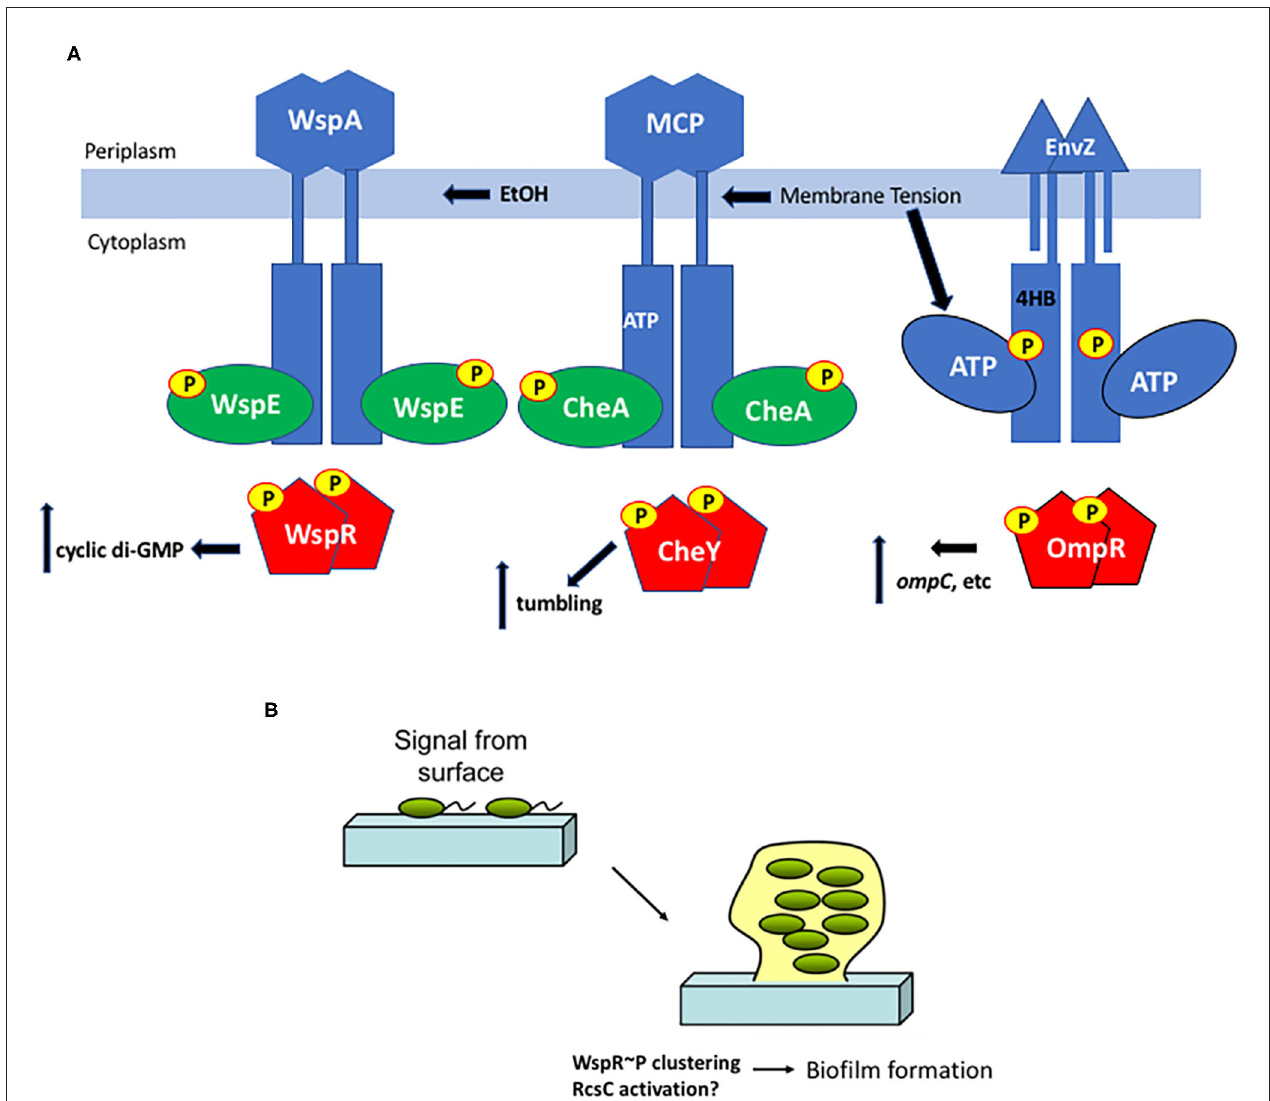
FIGURE 3 | Surface sensing in bacteria. (A) Membrane tension from osmotic stress, altered lipids or EtOH produced from a co-infection with C. albicans alters the chemoreceptors WspA and MCPs and/or the EnvZ HK directly and stimulates ATP turnover, increasing RR phosphorylation in turn, resulting in a change in output, depending on the RR. (B) Interaction with a surface is an early step in biofilm formation. Cells transition from the motile, planktonic state to interact with a surface via pili or other appendages and then begin the biofilm process. Deformation of the bacterial cell as it encounters a surface could then drive signaling steps that eventually lead to aggregation and production of matrix